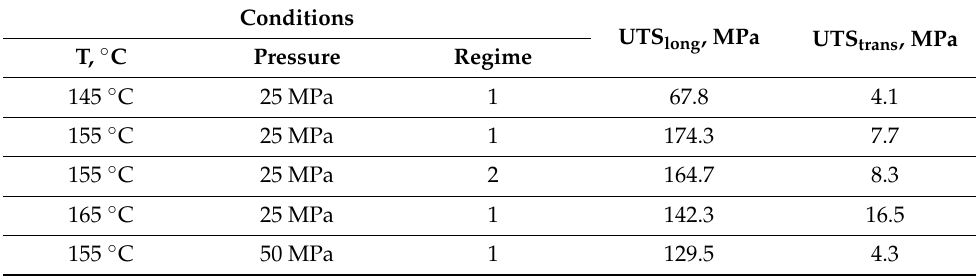
Table 2. Ultimate Tensile strength of SRCs in longitudinal and transverse